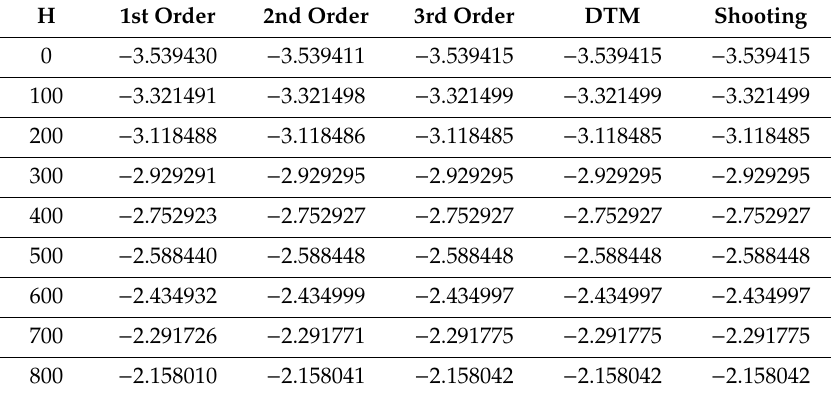
Table 1. Comparison of the di ff erential transform method (DTM) and shooting results with the spectral homotopy analysis method (SHAM) approximate results for F (cid:48)(cid:48) ( 0 ) when α = 5,Re = 50, h = − 0.95 for increasing values of H .